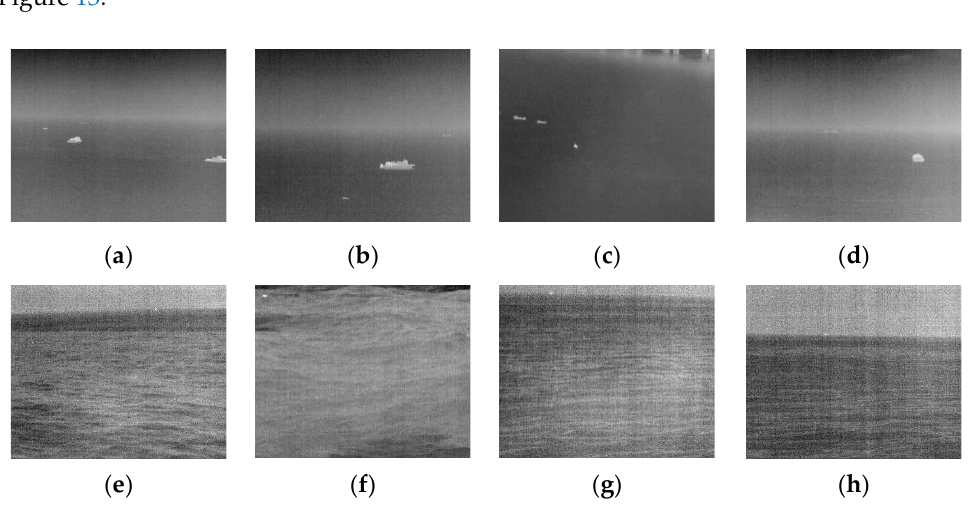
Figure 13. Typical marine infrared target images. ( a ) A calm sea image containing two targets with complex contours and two dim targets; ( b ) a calm sea image with a large ship target and two dim targets, one of which is near the sea line; ( c ) a calm sea image with three small targets; ( d ) a calm sea image with a medium target with a fuzzy dim target near the sea line; ( e ) a rough sea image with a dim point target near the sea antenna; ( f ) a rough sea image with a significant wave fluctuation, and there is a target in the upper left corner; ( g ) a rough sea image with great horizontal wave texture, and there is a target at the top edge of the image; ( h ) a rough sea image with more sky area and a dim target at the sea line.